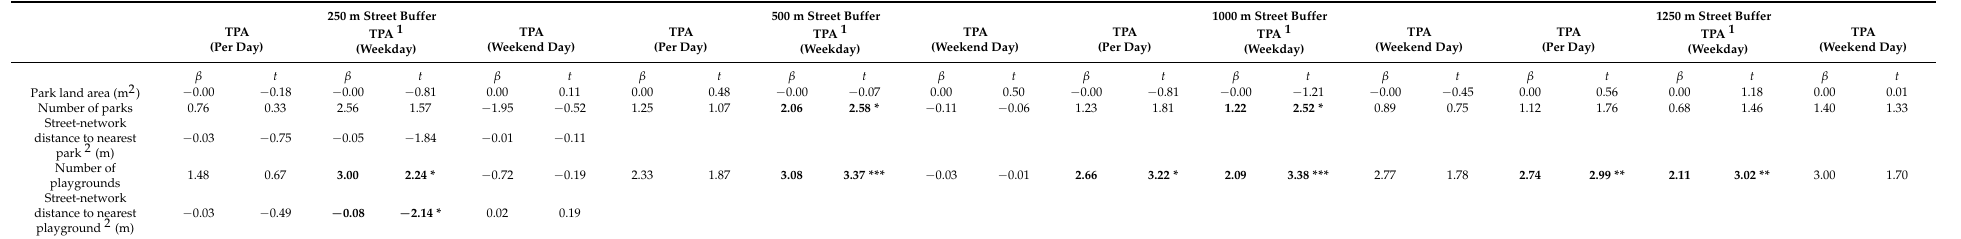
Table 4. Mixed-model regression results for the relationship between the availability and proximity to parks and playgrounds in the participants’ neighborhood and total physical activity